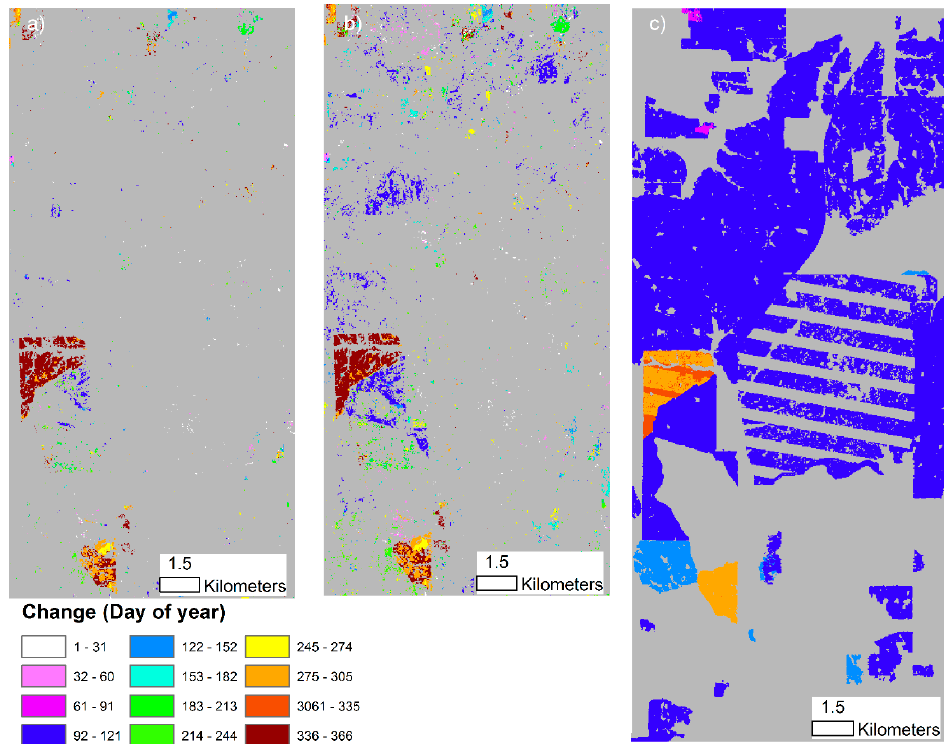
Figure A2. Illustration of ( a ) fire detection with default CCDC settings (six consecutive outlier observations as change criteria) and ( b ) fire detection with adjusted CCDC setting (four consecutive outlier observations as change criteria).